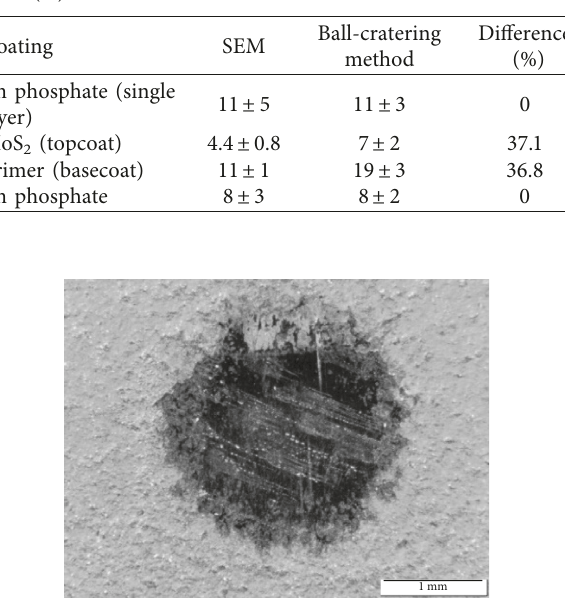
Figure 3: Surface of a single zinc phosphate coating after the ball- cratering